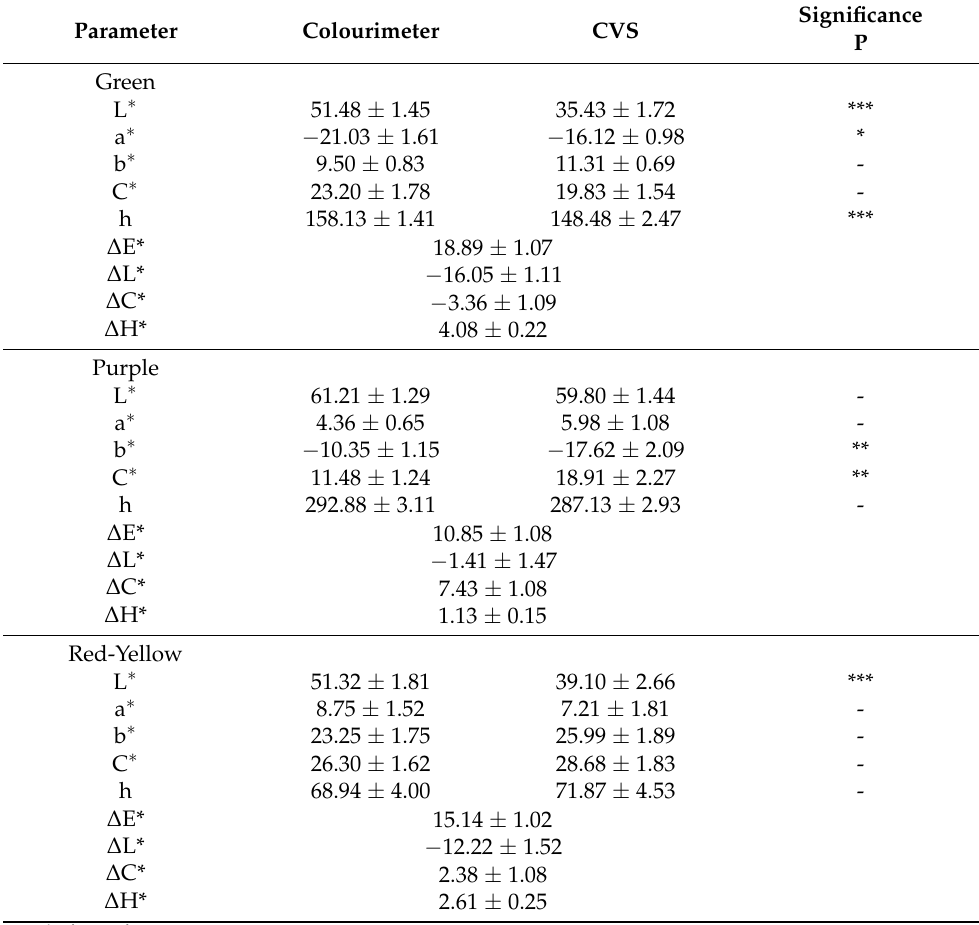
Table 2. Instrumental colour values (mean ± S.E.) of the CIELAB colour space of jadeite-jade using a colourimeter and the computer vision system (unpublished